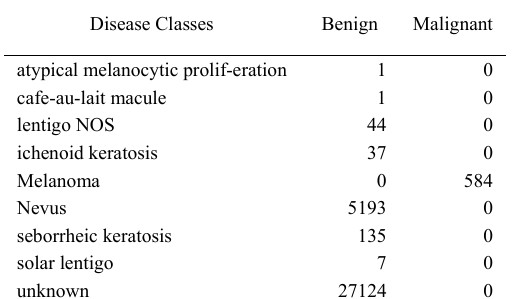
TABLE 1 DISEASE CLASSES DIVIDED INTO BENIGN AND